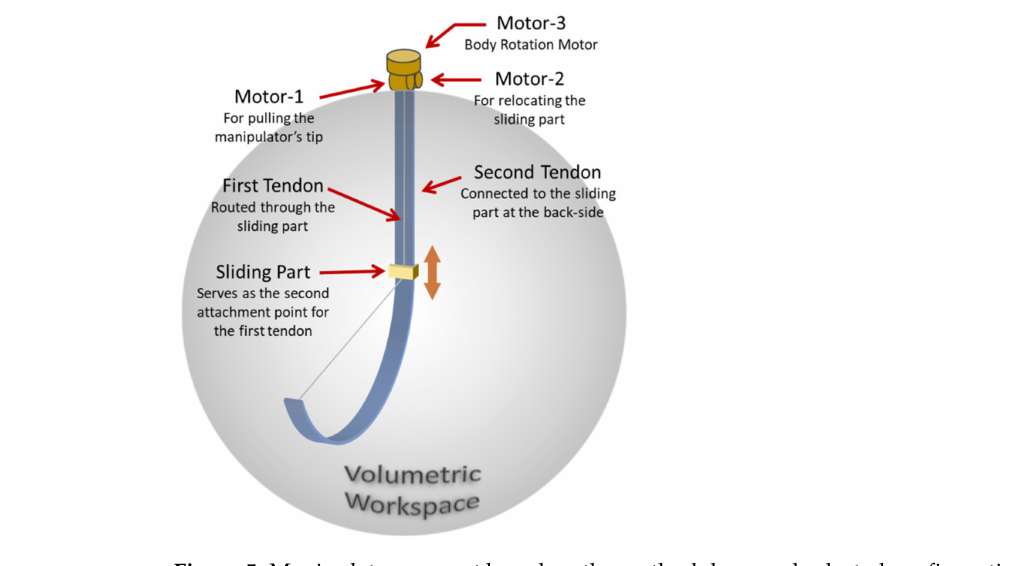
Figure 5. Manipulator concept based on the methodology and selected configuration. The tendon pulling the manipulator’s tip is routed through the ACTR towards the relative motor at the base.